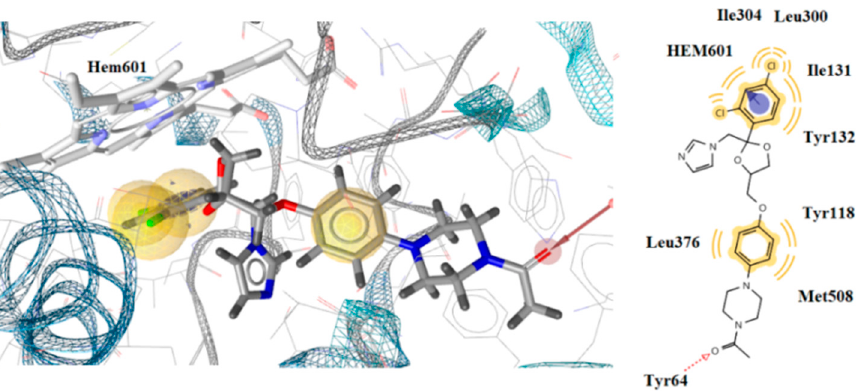
Figure 6. Docked conformation of ketoconazole in lanosterol 14 α -demethylase of C . albicans (CYP51 ca ).